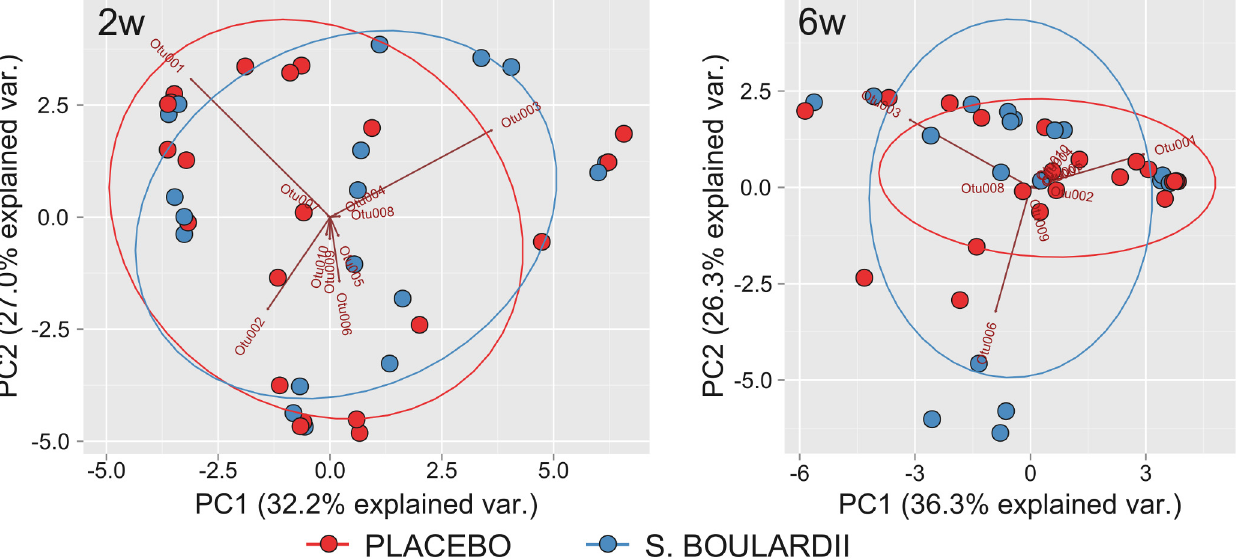
Fig 7. PCA analysis of the preterm infant gut microbiome grouped according to the administration of Saccharomyces boulardii or placebo, categorized according to the time points 2 (2w) and 6 (6w) weeks following supplementation. Only ten of the most abundant OTUs are shown. PC, principal component; var., variation; and S . Boulardii , Saccharomyces boulardii .